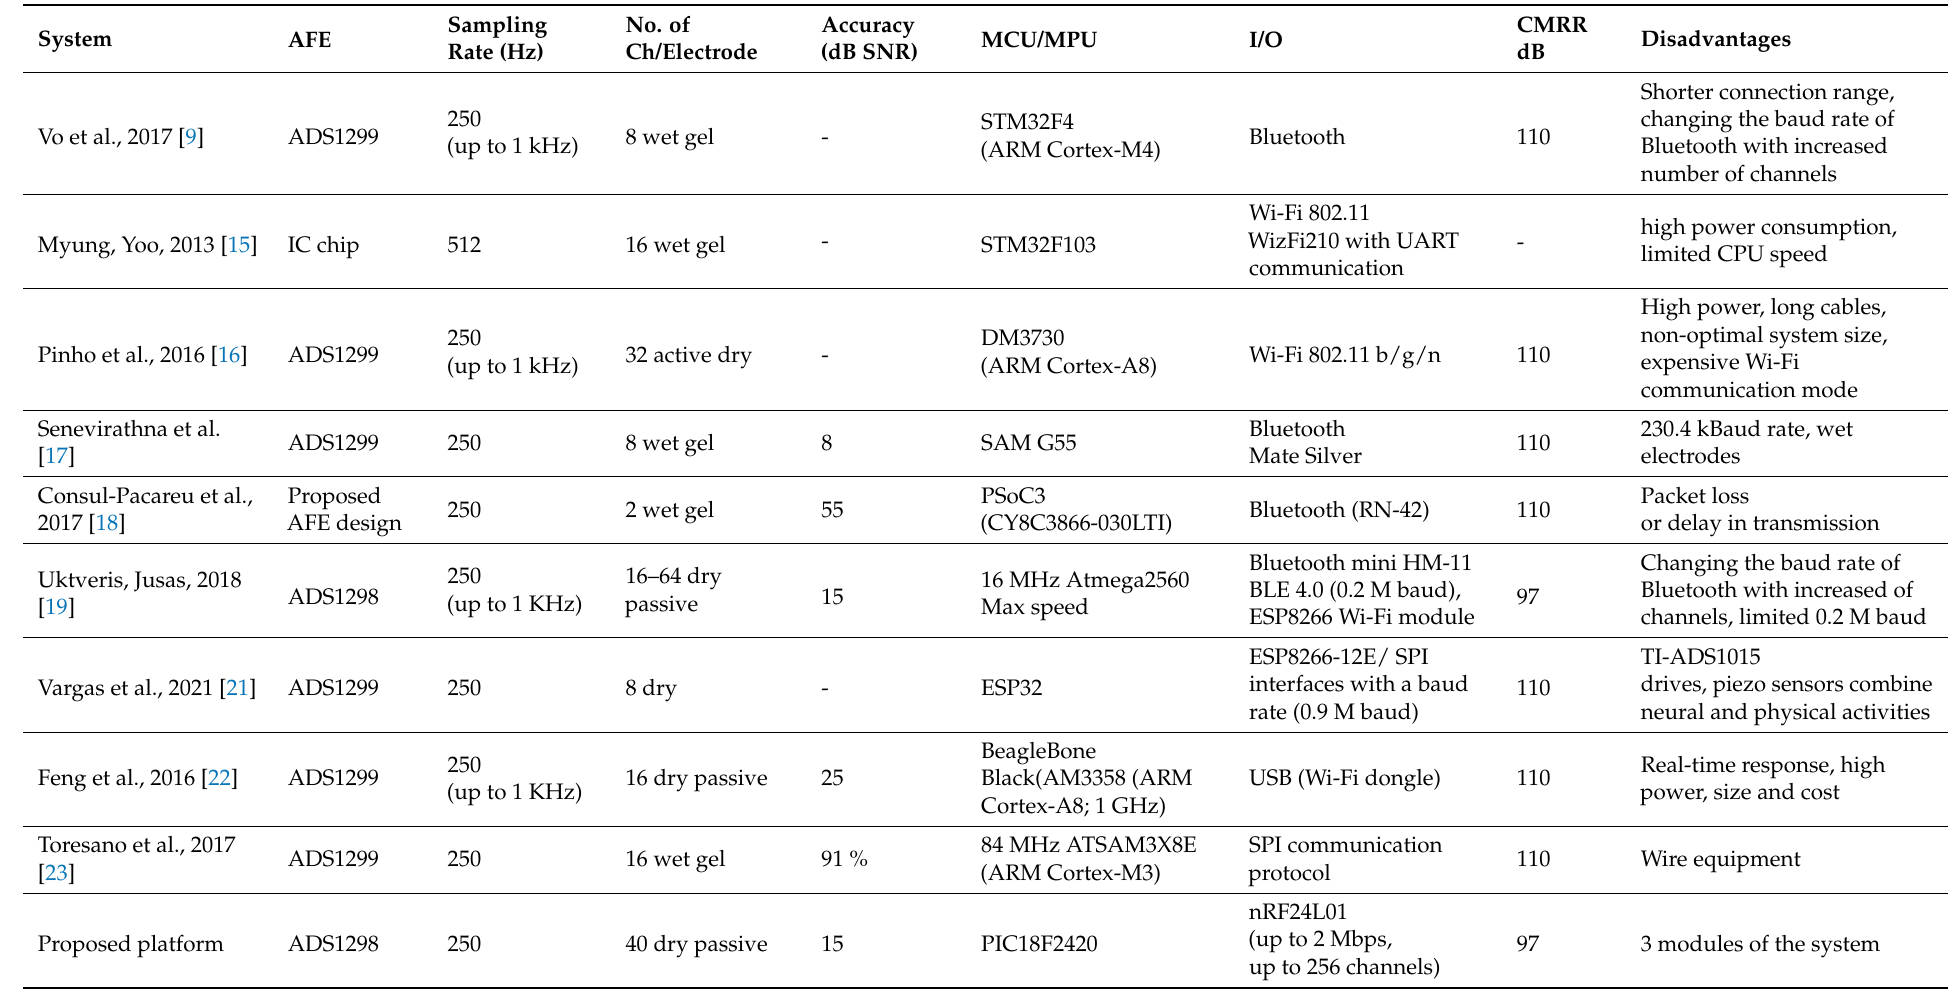
Table 1. Specifications of in-house EEG platforms, mainly built on low-noise, low power, and high-CMRR ADS1298/9 AFE chip. The dash (-) symbol indicates that the information is not